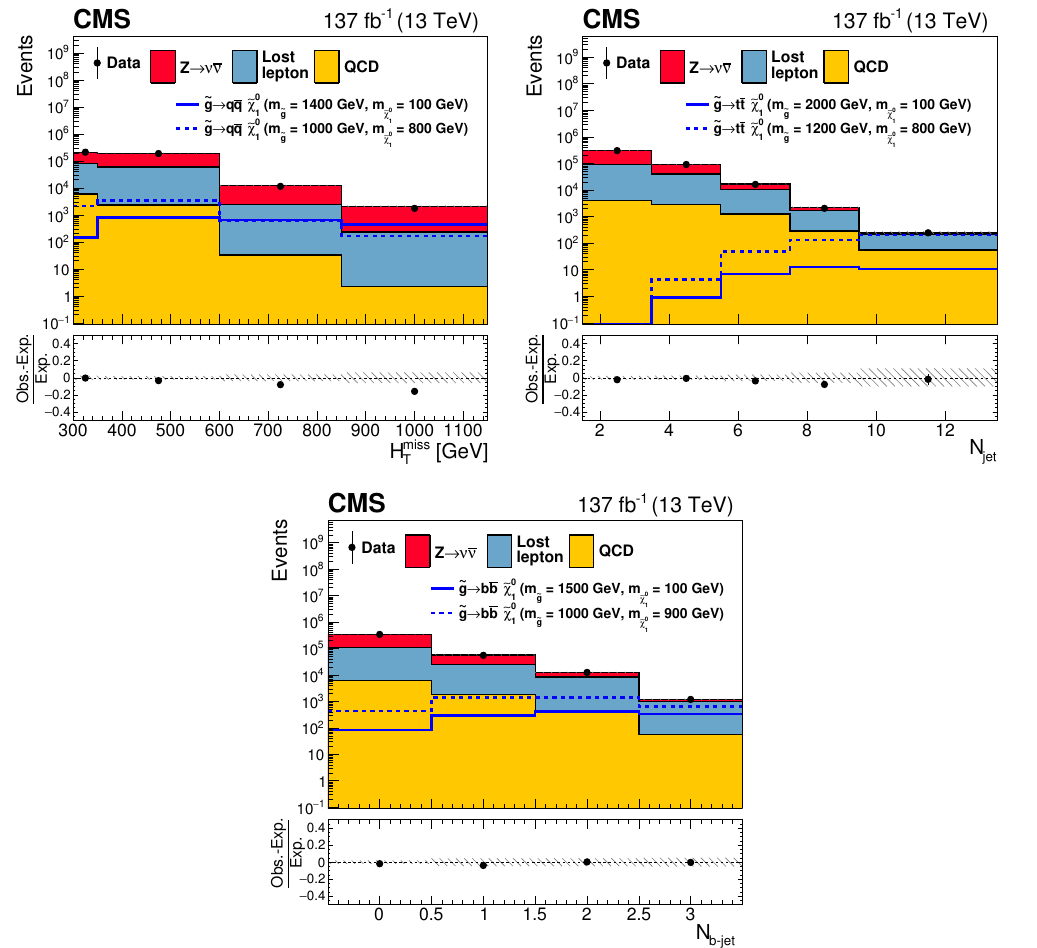
Figure 11 . One-dimensional projections of the data and pre-(cid:12)t SM predictions in H miss N . The hatched regions indicate the total uncertainties in the background predictions. The b-jet (unstacked) results for two example signal scenarios are shown in each instance, one with (cid:1) m (cid:29) 0 and the other with (cid:1) m (cid:25) 0, where (cid:1) m is the di(cid:11)erence between the gluino or squark mass and the sum of the masses of the particles into which it decays.